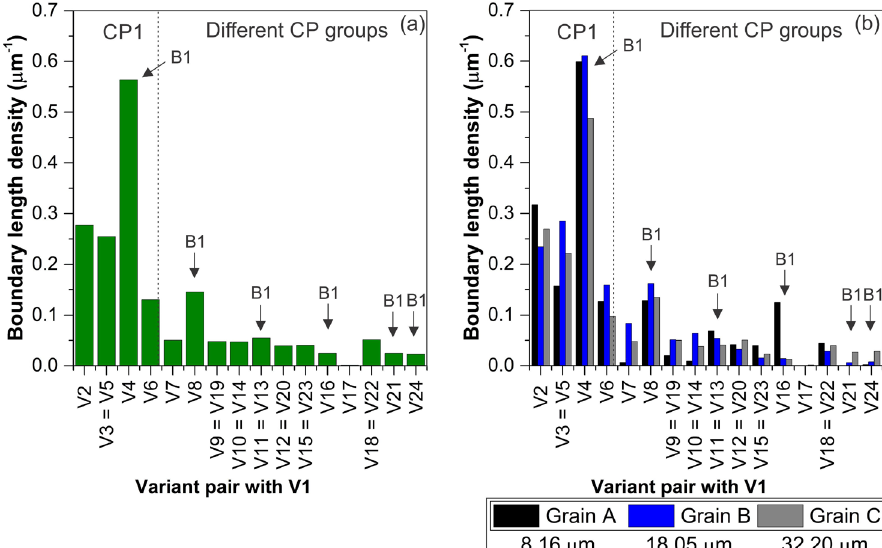
Figure 7. Grain boundary density distribution taking the variant 1 as reference for air-quenching treatment: (a) complete map and (b) grains A, B and C indicated Figure 3. Deviation: 3°.